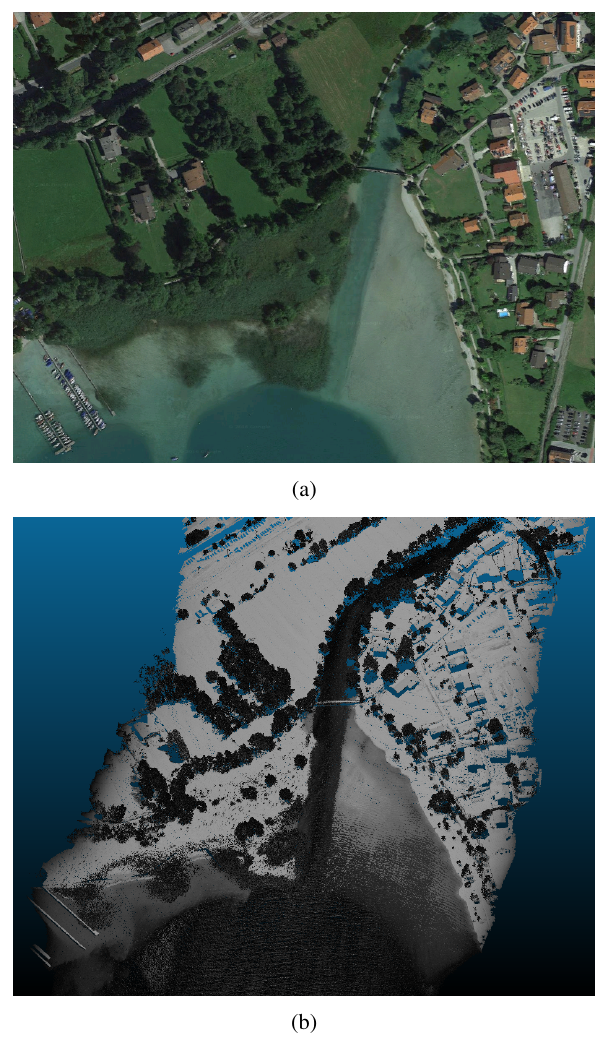
Figure 6. Region of the Tegernsee. (a): Google Maps Screenshot, (b): Scanned data with the points intensity as grey value